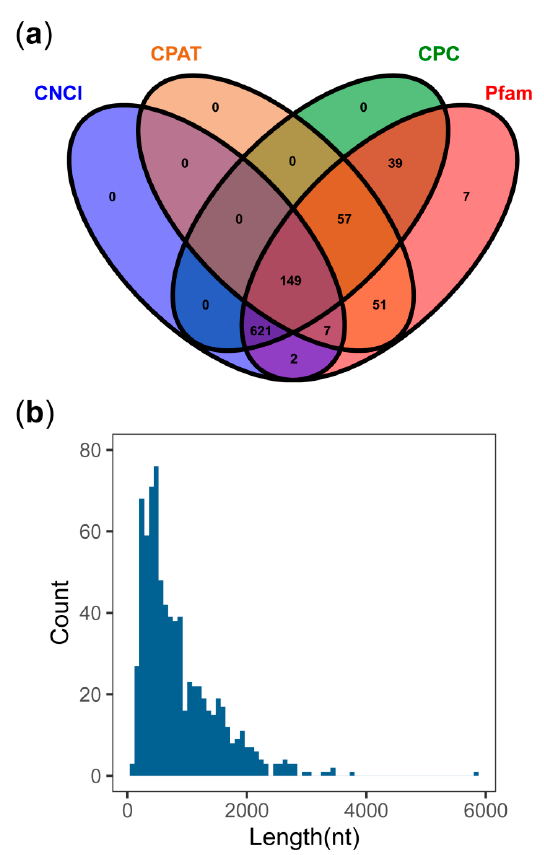
Figure 7. Identification of M. pasquieri long non-coding RNAs (lncRNA). ( a ) Venn diagram of lncRNAs predicted by CNCI, CPAT, CPC, and Pfam computational approaches. ( b ) Length distribution of identified lncRNAs.